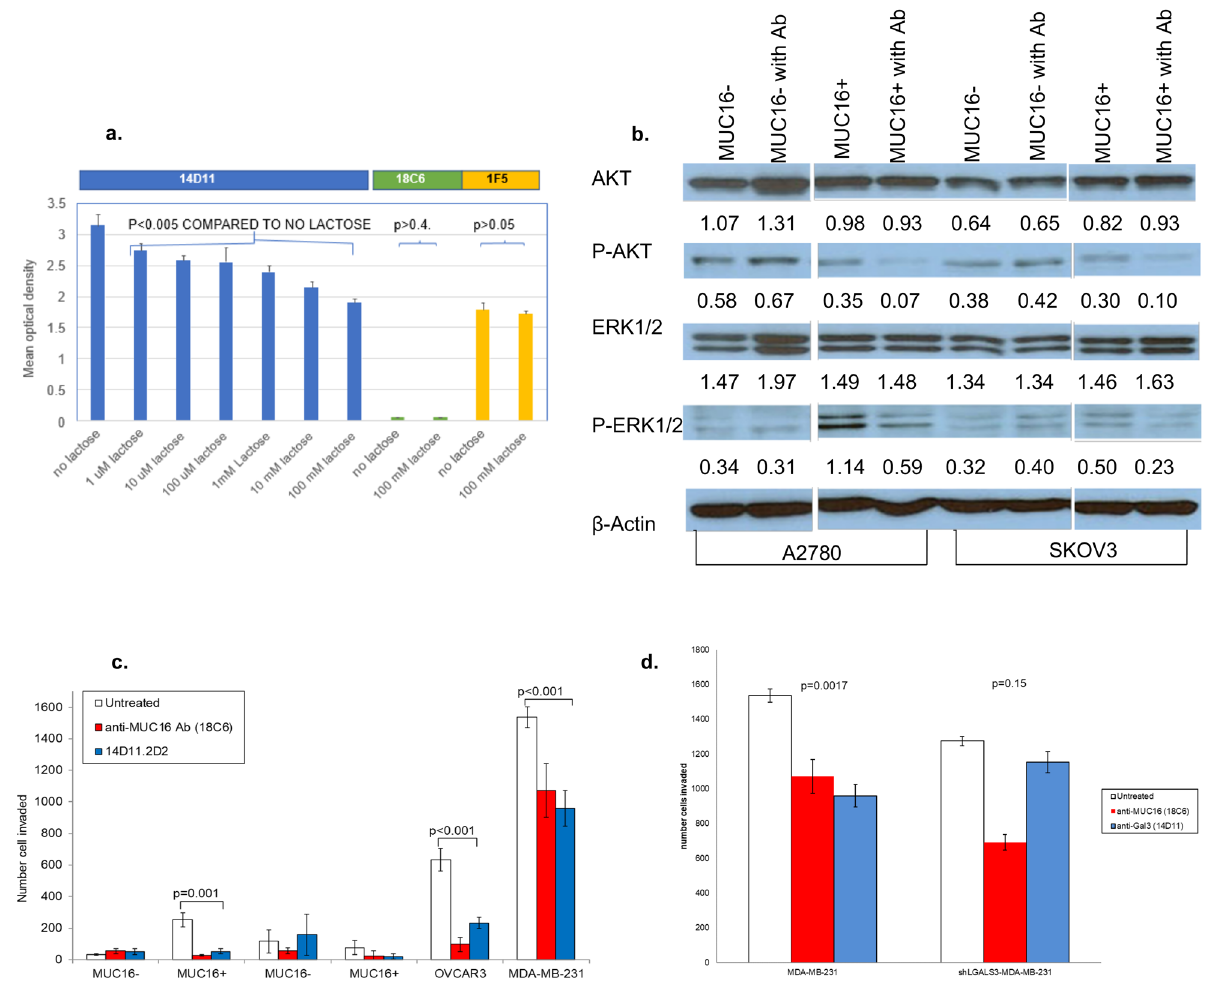
Figure 4. Anti-Gal3 monoclonal antibody, 14D11, inhibits MUC16-mediated tumorigenesis in vitro. ( a ) Direct ELISA for Gal3 binding to selected antibodies in the presence or absence of lactose. The presence of increasing lactose concentrations progressively inhibited the binding of Gal3 to 14D11, an isotype control antibody (18C6) and 1F5, an antibody reactive to the N terminal 15 amino acids of Gal3. Each lactose condition was compared to the zero lactose condition for the same antibody by paired t-test. ( b ) Effect of 14D11 on MUC16-mediated activation of ERK/AKT signaling in MUC16-expressing A2780 c344 and SKOV3 c344 cells after 48-h exposure to antibody. MUC16-negative A2780 and SKOV3 cells were used as controls. Densitometry was used to normalize the results against β-actin. ( c ) Effect of 14D11 on Matrigel invasion in MUC16-overexpressing SKOV3 c344 and A2780 c344 cells, and endogenous MUC16-expressing OVCAR3 cells. Anti-MUC16 N-glycosylation site antibody, 18C6, was used as a positive control. The values are the mean of triplicate well from a representative study and the invasion assays were repeated independently ≥ 3times. ( d ) Effect of 14D11 on Matrigel invasion in MDA-MB-231 and sh LGALS3 -MDA-MB-231 cells, performed as in fusion protein. The last 2 immunizations used human LGALS3 protein (OriGene; Rockville, MD). The immune sera from the mice were collected at the time of every immunization and screened for reactivity against LGALS3 by ELISA. Following the last immunization, 2 of the 5 immunized mice that showed high ELISA titers to the antigen were selected and IV boosted with the human LGALS3 protein at a dose of 10 µg immunogen/mouse (one mouse was planned to be sacrificed while the other was selected as a backup). The fusion and screening was performed according the protocols of the MSKCC monoclonal antibody facility and our prior reports 23,27 . To increase number of CBD directed antibodies, a second campaign was undertaken. A 23 amino acid custom peptide was synthesized from the sugar-binding domain of LGALS3, CNTKLDNNWGREERQSVFPFESG (called Peptide 1) (All peptides commercially supplied by Atlantic Peptides; Lewisburg, PA). The peptide sequence was chosen as it was noted to be conserved among various species and therefore likely represented a critical region of the protein. The peptide was then conjugated to keyhole limpet hemocyanin (KLH) using Imject Maleimide- Activated mcKLH Kit (Pierce; Rockford, IL), creating the KLH-Peptide 1. Four mice were immunized with KLH-Peptide 1 at 50 µg immunogen/mouse IP every 3 weeks for a total of 3 injections. Immune sera were col- lected and screened for reactivity against LGALS3 and Peptide 1 by ELISA. Following the last immunization, 2 mice were chosen to receive an IV boost of KLH-Peptide 1 at 10 µg immunogen/mouse, and 24 h later, one